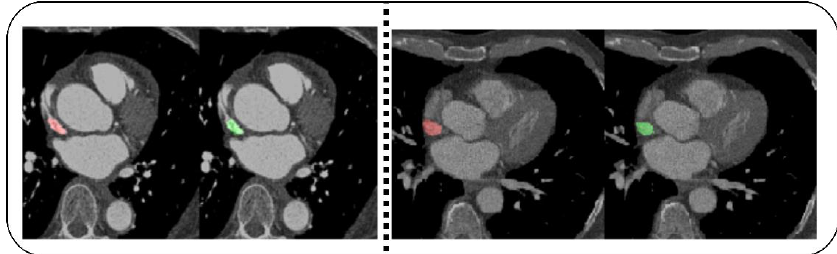
Figure 2. ( a ): Positive individual, ( b ): negative individual. Dataset 2 [5] consists of CT angiography images of 200 patients. This dataset used images from a multicenter registry of patients who had undergone clinically indicated coronary computed tomography angiography (CCTA). The annotated ground truth in- cluded the ascending and descending aortas (PAA, DA), superior and inferior vena cavae (SVC, IVC), pulmonary artery (PA), coronary sinus (CS), right ventricular wall (RVW), and left atrial wall (LAW). Figure 3 shows the CT images of dataset_2. Table 2 outlines the description of the datasets. Both datasets contain CT images of CAD and Non-CAD pa- tients.